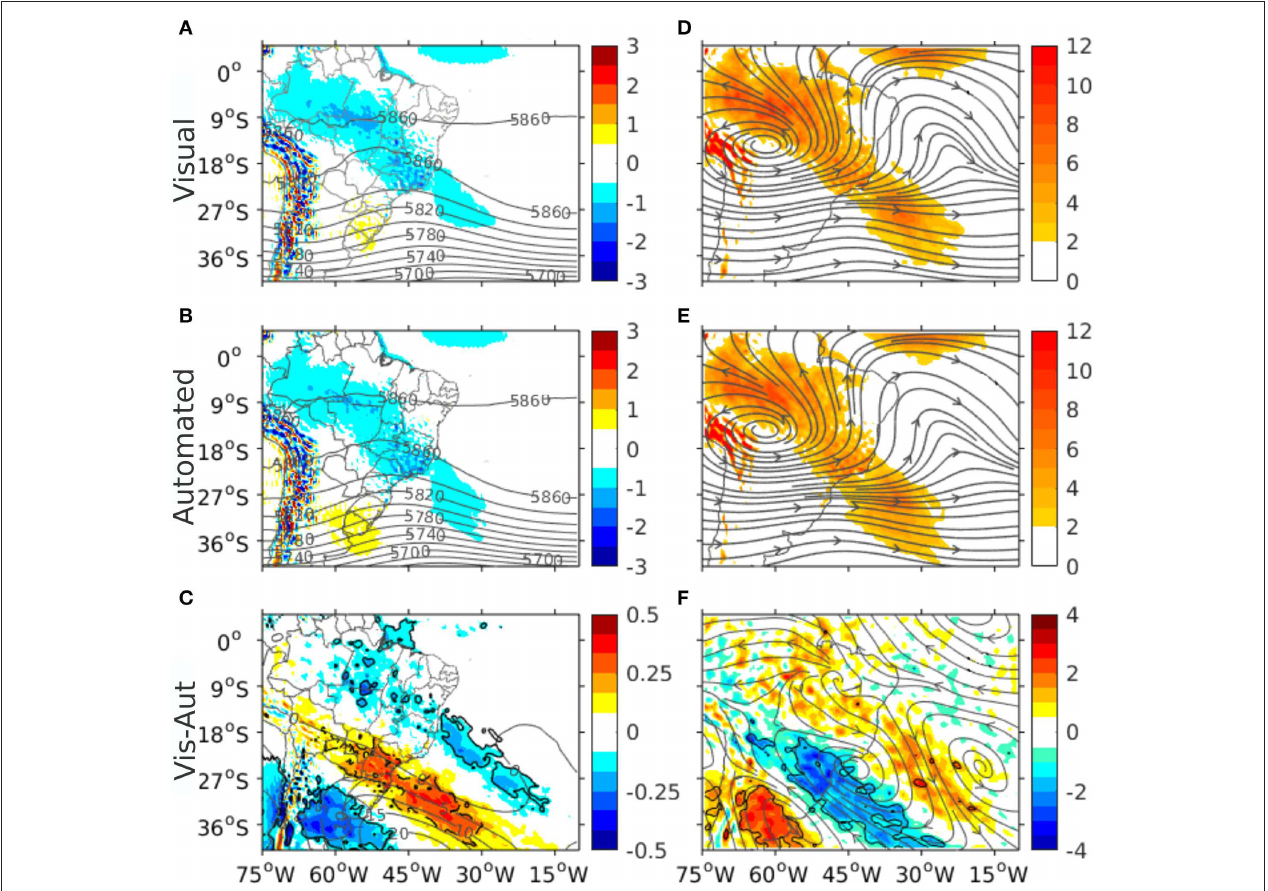
FIGURE 7 | As in Figure 5 , but for (A,B) omega velocity (colors in hPa s − 1 ) and geopotential height (lines with intervals of 20 m) in 500 hPa and (D,E) divergence of mass (colors in × 10 6 s − 1 ) and streamlines in 200 hPa. (C,F) Are the difference between visual (A,D) and automated (B,E) methods with significant t-test values ( > 95%) inside the solid and dashed lines.